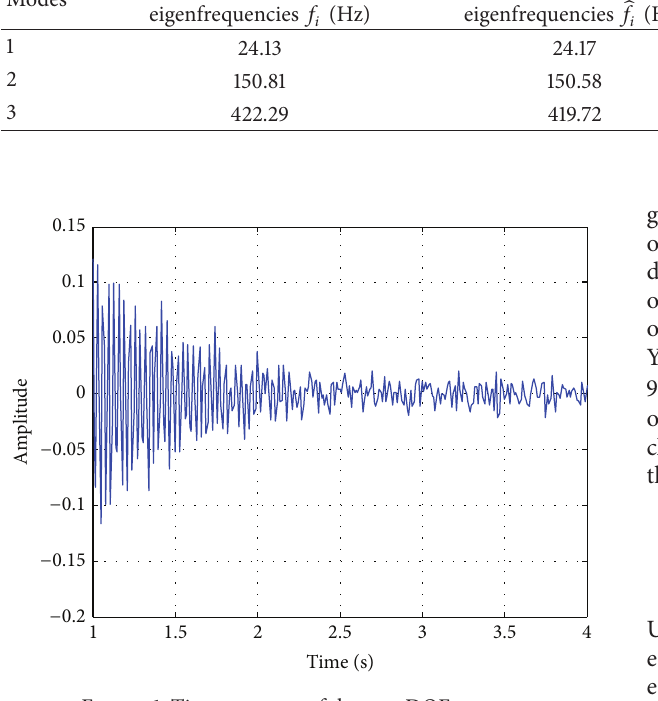
Figure 1: Time response of the two-DOF